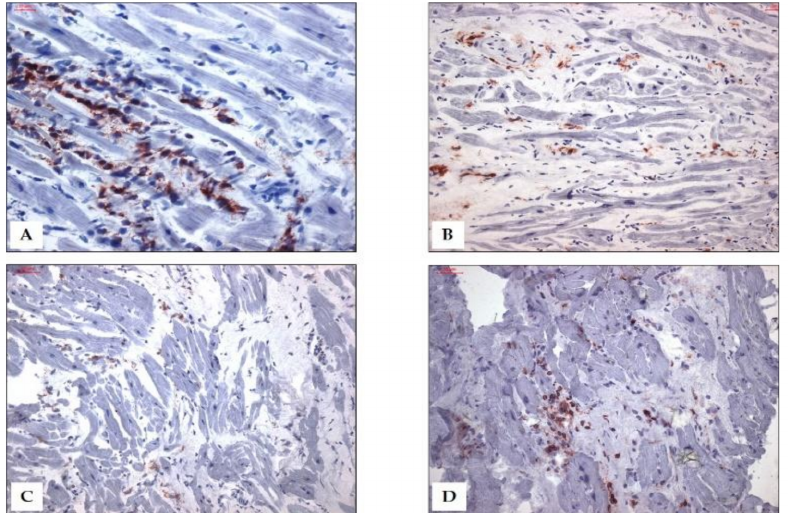
Figure 3. Representative immunohistological images. ( A ) Active myocarditis with B19V replicative activity. Massively increased CD3 positive t lymphocytes are stained in red/brown. Scale bar = 20 µ m. ( B ) Inflammatory cardiomyopathy with positive detection of enterovirus genomes. Increased CD45R0 + T-memory cells are stained in brown. Scale bar = 50 µ m. ( C ) EMB with positive detection of SARS-CoV-2 RNA. Increased cytotoxic perforin + cells are stained in red/brown. Scale bar = 50 µ m. ( D ) Staining of increased CD3 + t lymphocytes as a suspected consequence of COVID-19 vaccination. Scale bar = 50 µ